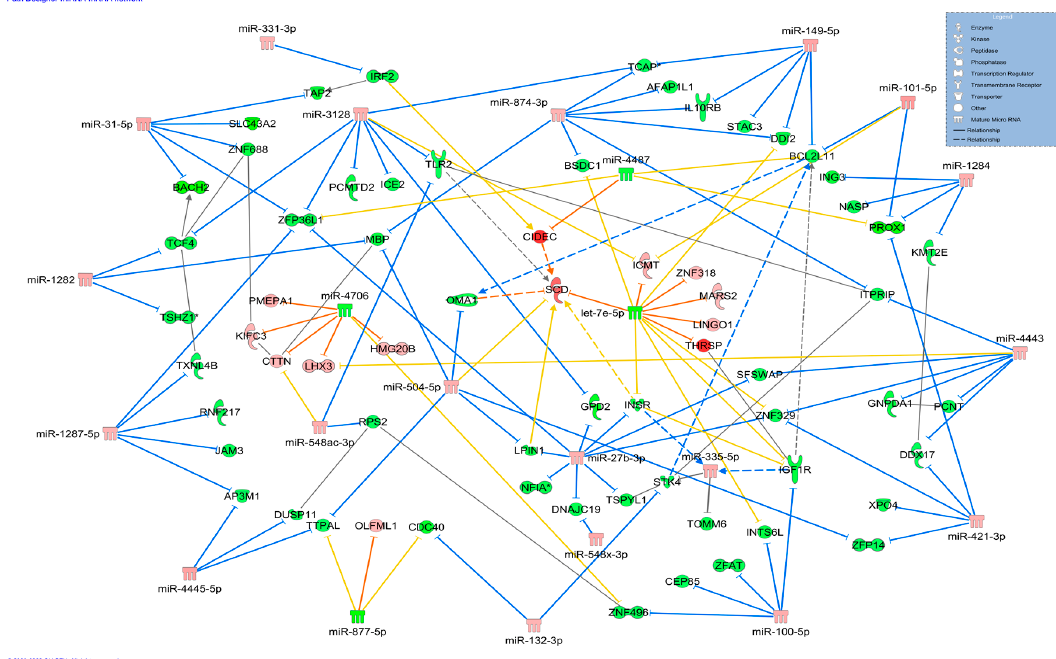
Figure 1. MicroRNA-target gene co-expression network constructed using Ingenuity Pathway Analysis (IPA). Here, upregulation and downregulation of microRNA (miRNA)/gene are represented by red and green, respectively. The intensity of color represents the level of expression, e.g., intense red means higher expression, while light red is low expression of a miRNA or DEG. The gene inhibition and activation by miRNA is shown by blue and orange lines, respectively. Further, predicted targets of the miRNAs are connected with yellow lines. Transcription factors, receptors, mature miRNA etc. are represented by different shapes in a blue box on top right of the image.